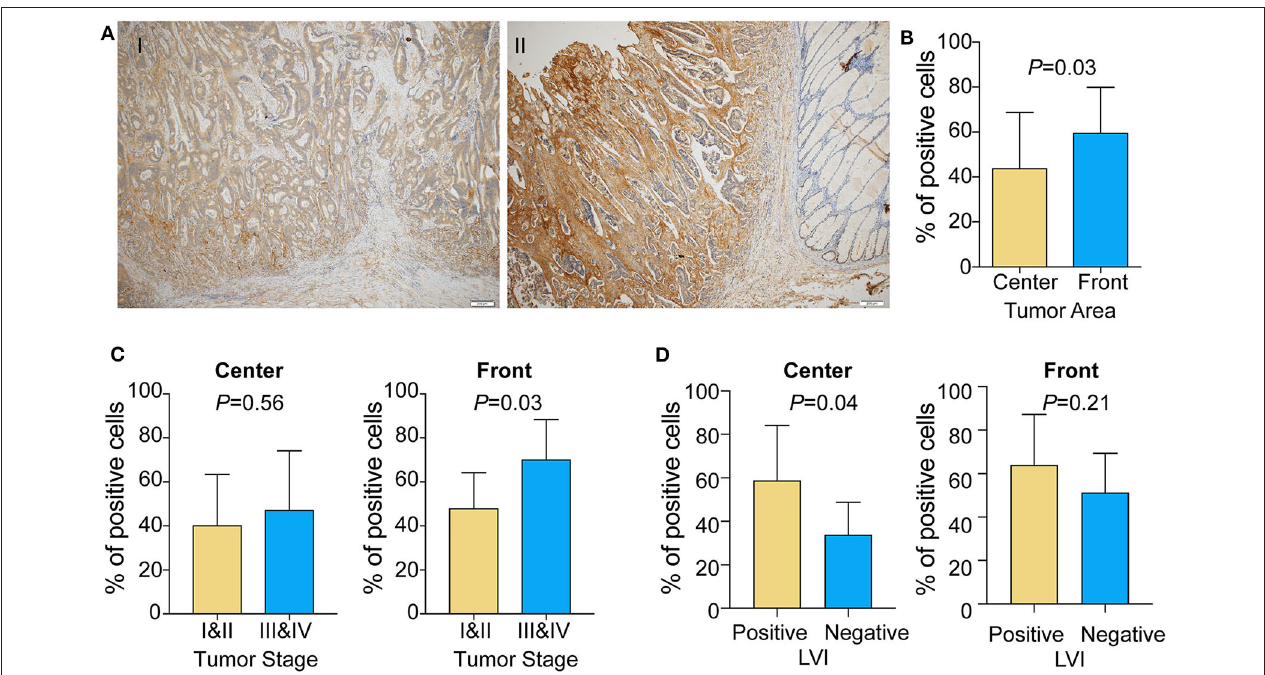
FIGURE 4 | FAP expression is enriched in the tumor front area in colorectal tumor. (A) Representative micrographs of FAP distribution in the tumor center and at the tumor front area. (I) FAP expression is higher at the tumor front compared to the tumor center; (II) FAP expression does not show significant difference between tumor center and tumor front, whereas neighbor non-neoplastic colonic mucosal stroma is completely negative. Scale bar: 200 µ m. (B) Percentage of cells showing FAP-positive staining in the tumor front and tumor center areas ( n = 19). (C) Percentage of cells showing FAP-positive staining in tumor center (left) and front (right) in early and advanced tumor stage. (D) Percentage of cells showing FAP-positive staining in tumor center (left) and front (right) with lymphovascular invasion. Statistical analyses were performed using Fisher exact tests for categorical variables and Mann–Whitney U -tests for numeric variables. All tests were two-sided, and p < 0.05 was considered statistically significant. Data in (B–D) are represented as mean ±